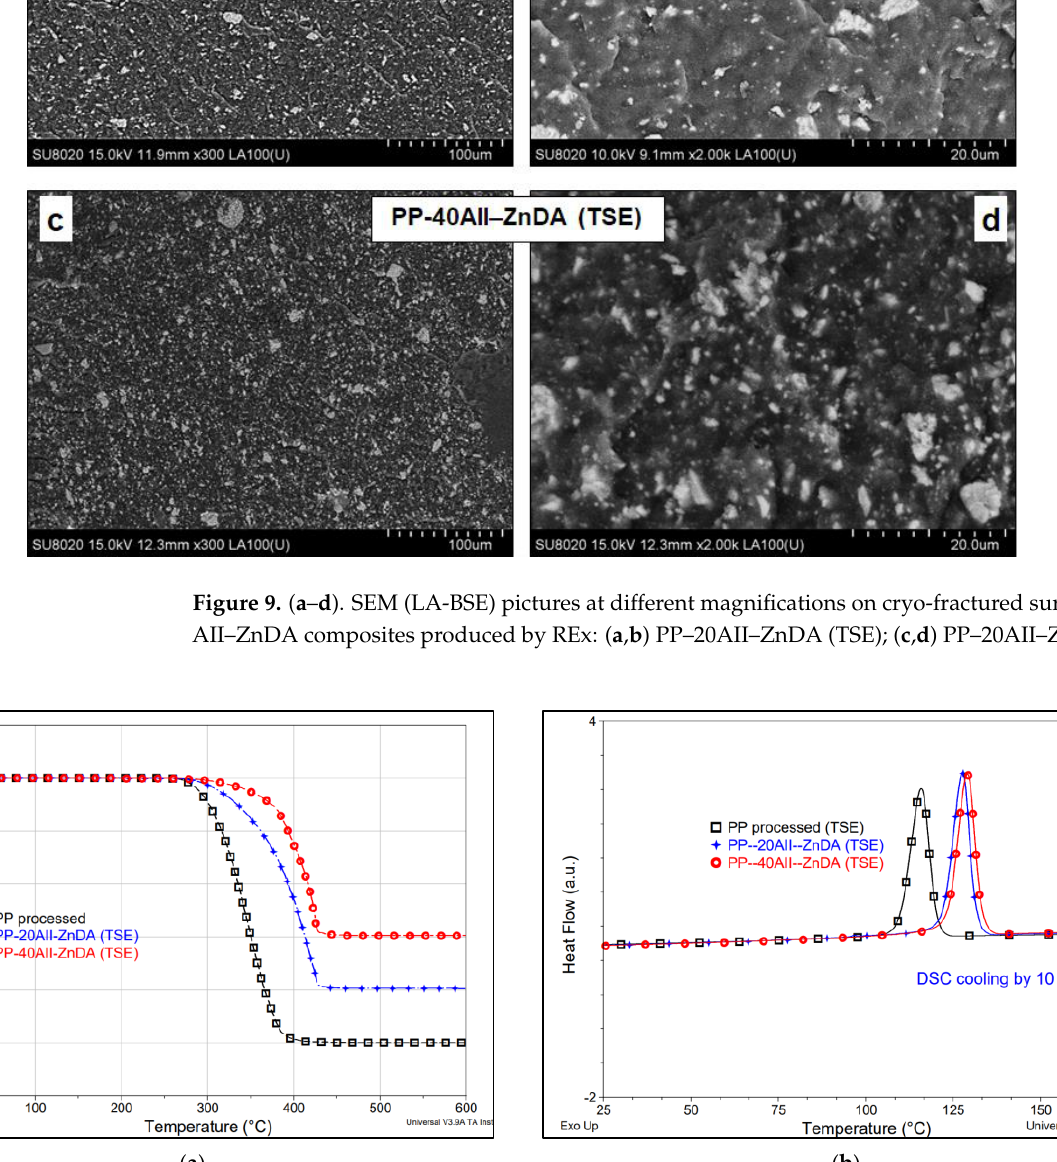
Figure 10. ( a , b ) Comparative thermal analyses of PP and PP – AII – ZnDA composites produced by REX: ( a ) TG traces; ( b ) crystallization from the molten state (DSC method, cooling by 10 °C/min).